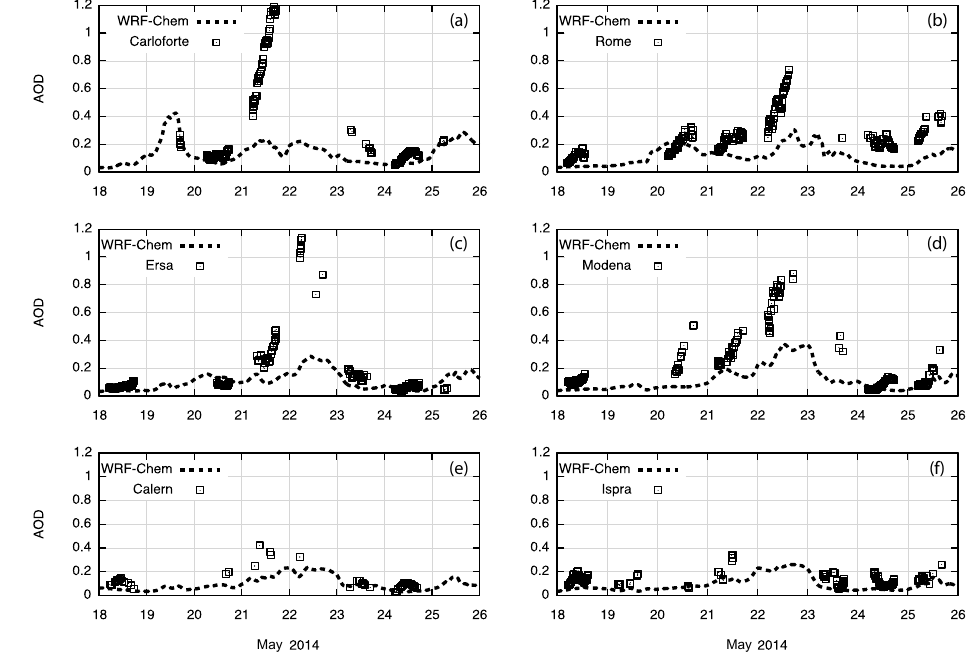
Figure A3. As in Fig. 6 (right panel) except that the S11 rather than the S01 configuration is used.